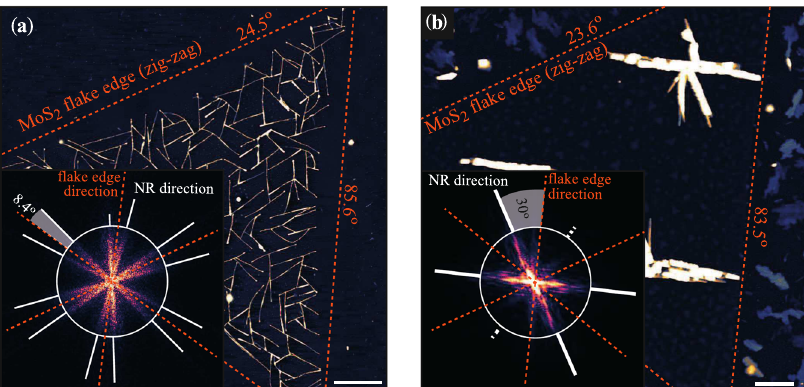
Fig. 3 Orientation control of nanoribbons. a (scale-bar: 5 μ m) CVD MoS 2 NRN with ribbons nearly parallel to the fl ake edges (zigzag direction), using 6P molecules for the self-assembled mask. Inset shows 2D-FFT analysis of the NR directions with respect to the triangular fl ake edges. 2D Fast Fourier Transform (2D-FFT) image is rotated by 90 ∘ to represent real-space directions. b (scale-bar: 1 μ m) Similar to a only using DHTA7 molecules for the self-assembled mask, and resulting in NRs in armchair direction (perpendicular to fl ake